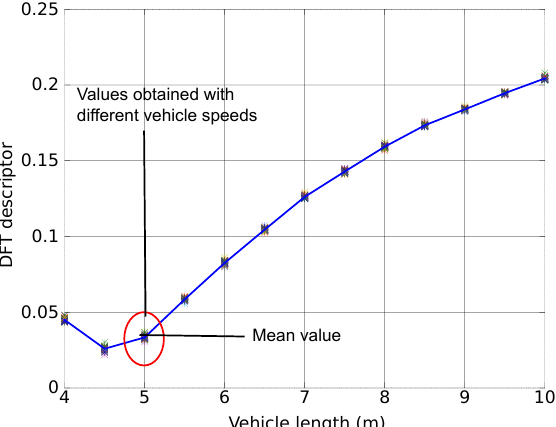
Figure 3. Software simulator: Signature descriptor for vehicle length from 4 m to 10 m, and speed from 20 km/h to 120